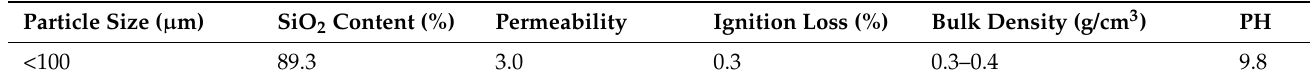
Table 2. Main parameters of diatomite.